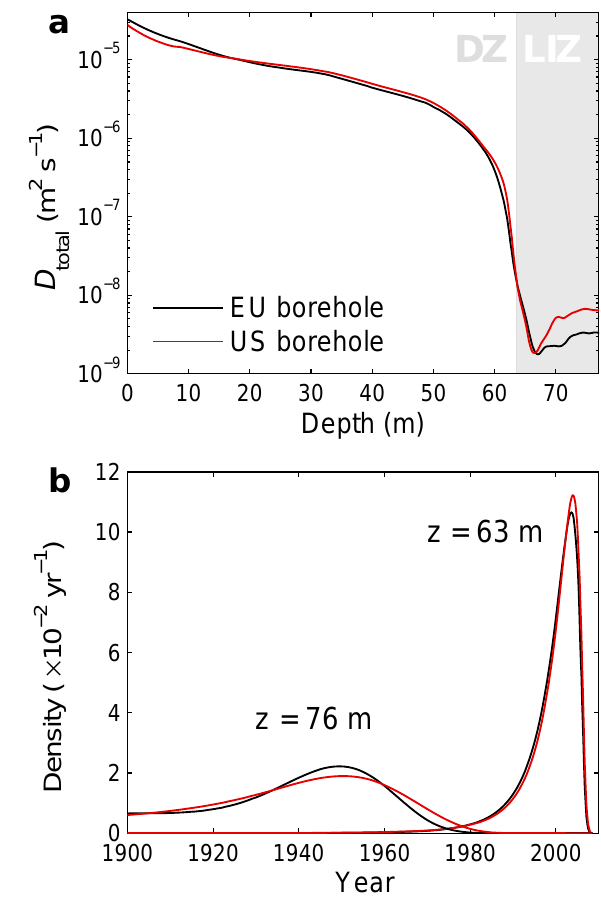
Fig. 7. EU borehole modeled CO 2 age distribution densities for (a) depth z = 63m (lock-in depth) and (b) depth z = 78 m (bot- tom of LIZ). On the horizontal axis are calendar years C.E.; dec- imal sampling year is 2008.54 (i.e. mid July). Age distributions are calculated by applying a surface forcing which is unity for 0 . 2 ≤ t < 0 . 4yr, and zero elsewhere.